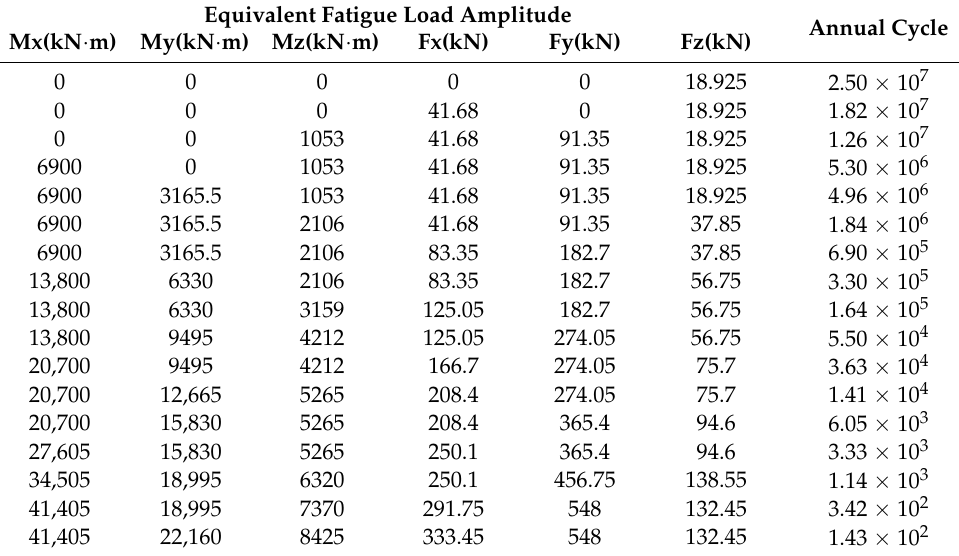
Table 4. Equivalent fatigue loads with respect to the tower base.